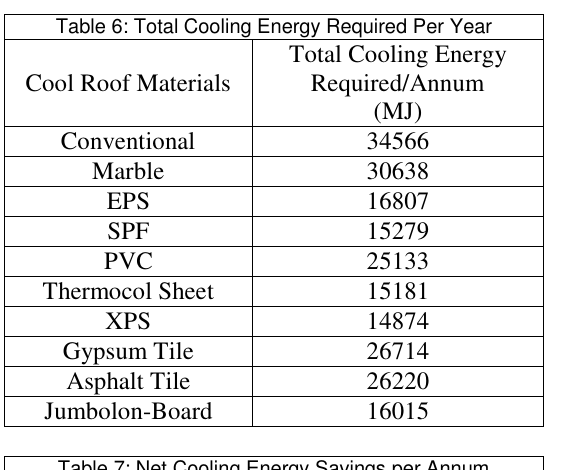
Table 7: Net Cooling Energy Savings per Annum